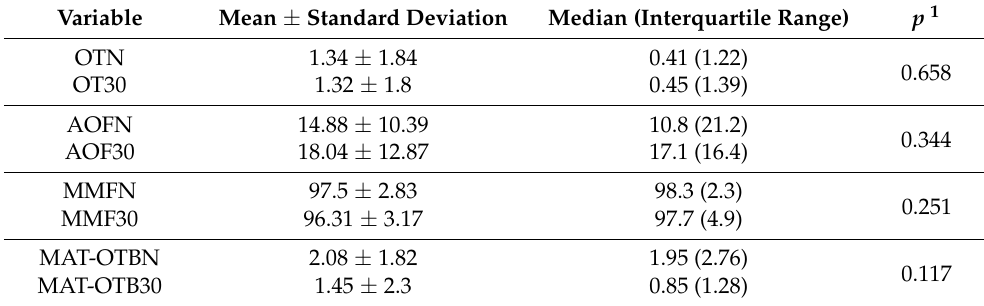
Table 2. Descriptive statistics and p values obtained from the applied Wilcoxon Signed Ranks